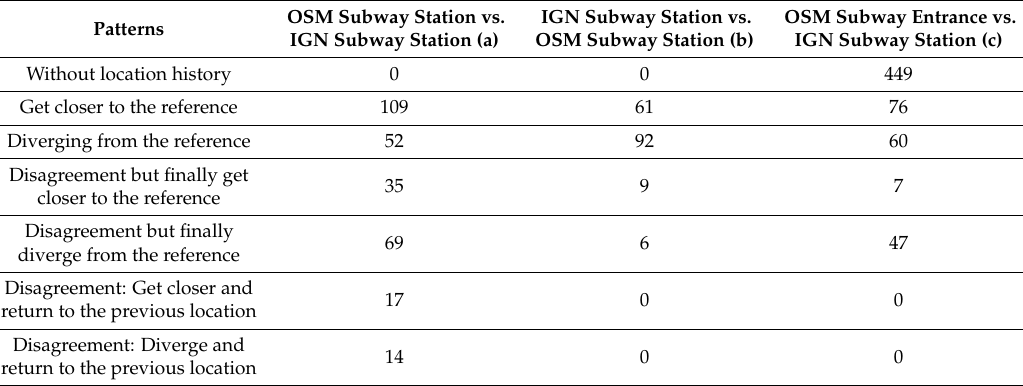
Table 10. Change location patterns for subway stations and subway entrances with respect to a reference.